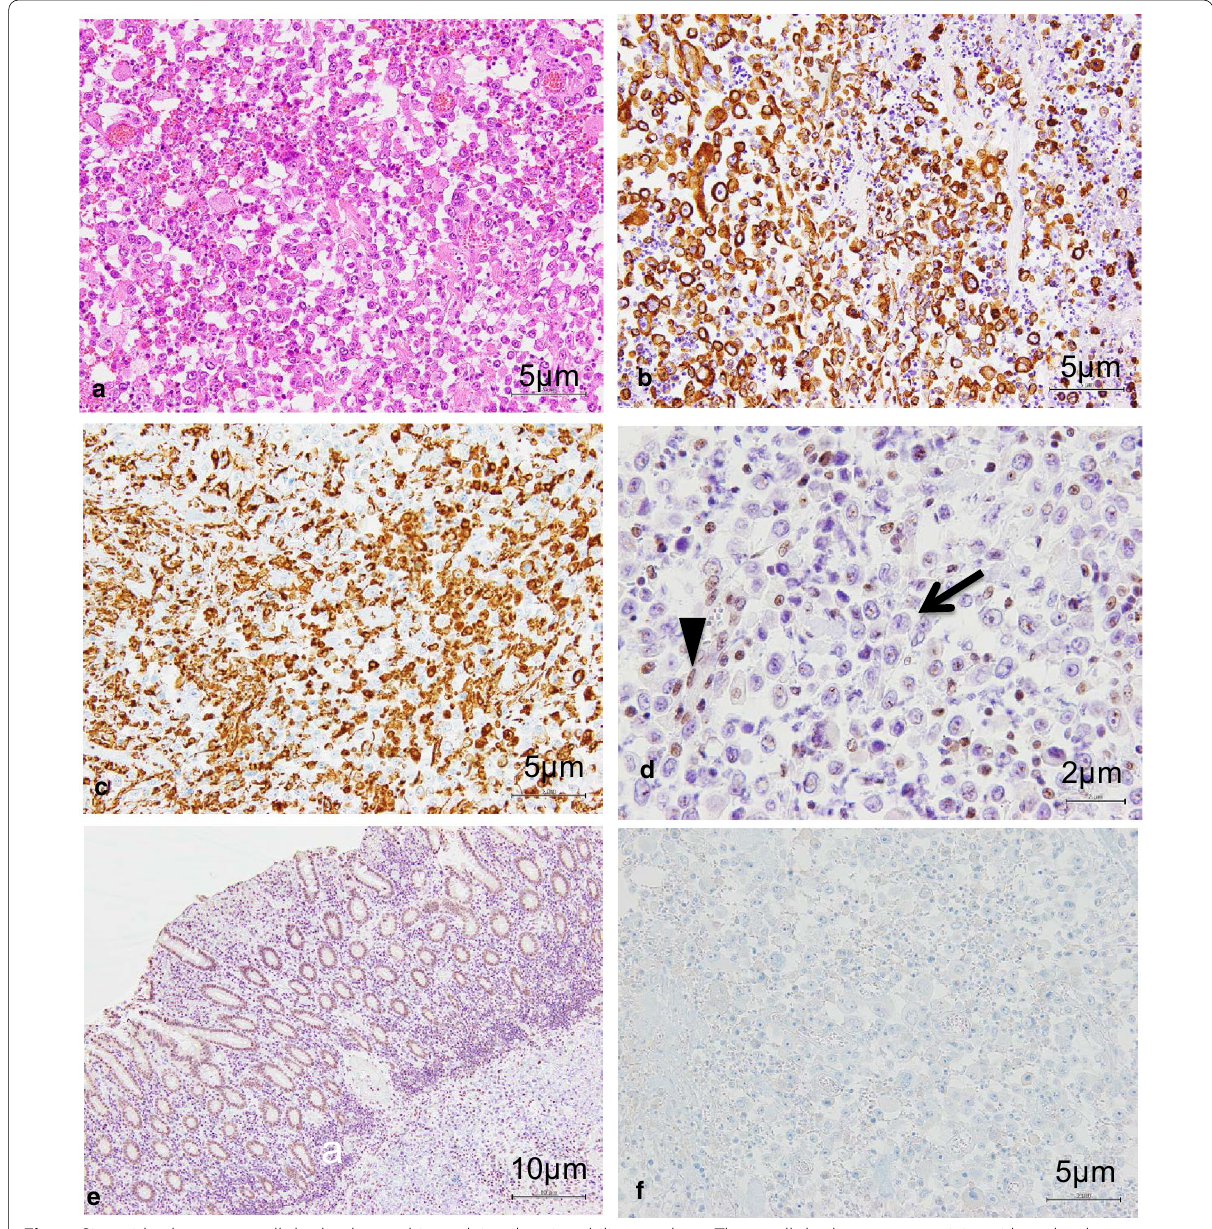
Fig. 4 Sigmoid colon tumor cells had polymorphic nuclei and eosinophilic cytoplasm. These cells had poor connectivity with each other. These characteristics are called rhabdoid features, because the morphology of these cells is similar to that of rhabdomyosarcoma tumor cells (HE 200) ( a ). Immunohistochemical examination showed that the tumor cells were positive for both epithelial (cytokeratin AE1/AE3) ( 200) × × ( b ) and mesenchymal cell markers (vimentin) ( 200) ( c ). These tumor cells were negative for INI1 (arrow), on the other hand, the surrounding × non-neoplastic cells were positive for INI1 (arrowhead) ( 400) ( d ). Contrast to the tumor cells, non-tumor crypt epithelium cells were INI1 positive × ( 100) ( e ). The tumor cells were negative for CDX2, which is a marker of colonocytes differentiation ( 200) ( f × ×